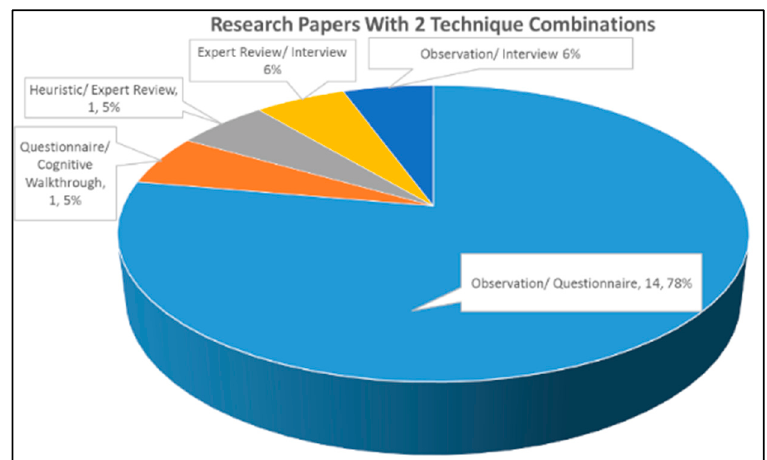
Figure 10. Papers with two technique combinations.